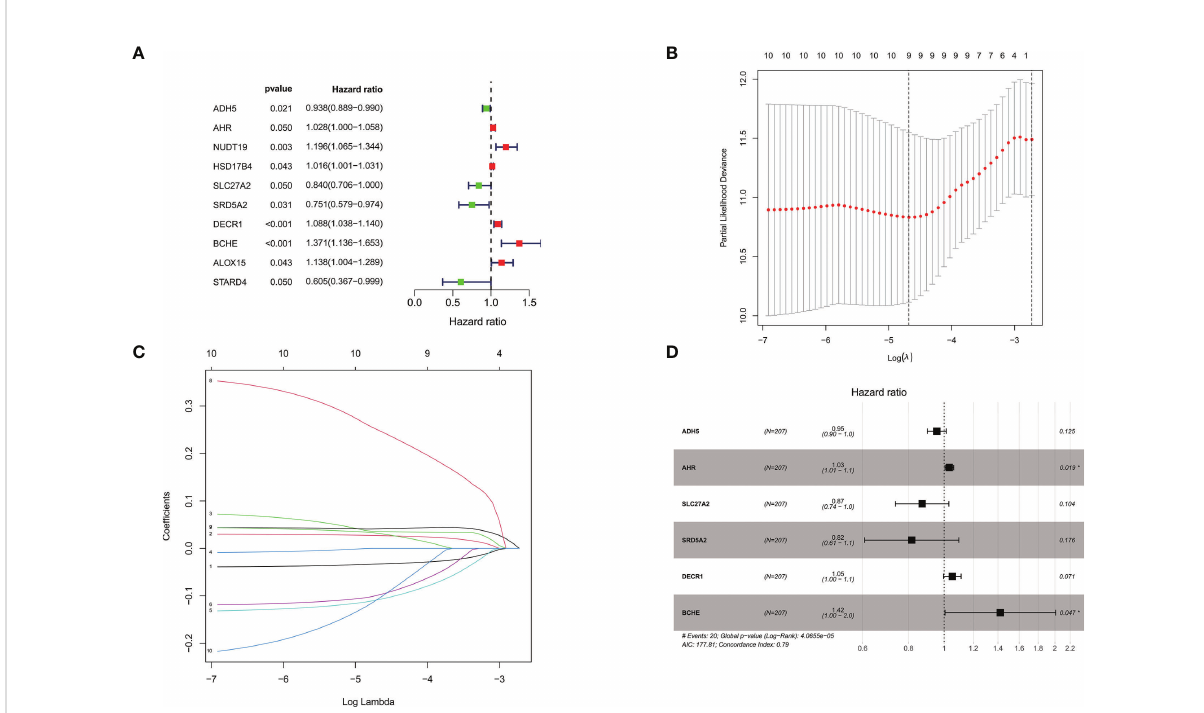
FIGURE 3 (A) . Univariate cox analysis of the TCGA cohort training group screened the forest plot of differential genes associated with BCR; (B, C) 9 genes were further screened by LASSO regression analysis; (D) . Multivariate cox regression analysis was performed to fi nally screen the forest plot of 6 genes associated with BCR. *P <